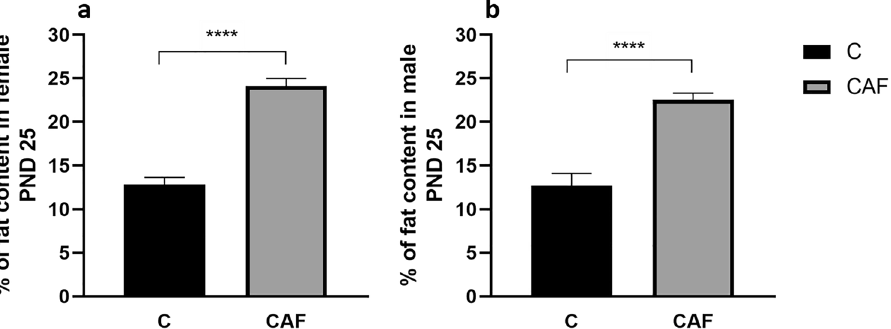
Figure 4. Percentage of fat content in offspring on PND 25. ( a ) Percentage of fat content in female offspring on PND 25 (****p < 0.001; females n = 9–13/group); ( b ) percentage of fat content in male offspring on PND 25 (****p < 0.001; males n = 7–10/group); C control group, CAF cafeteria